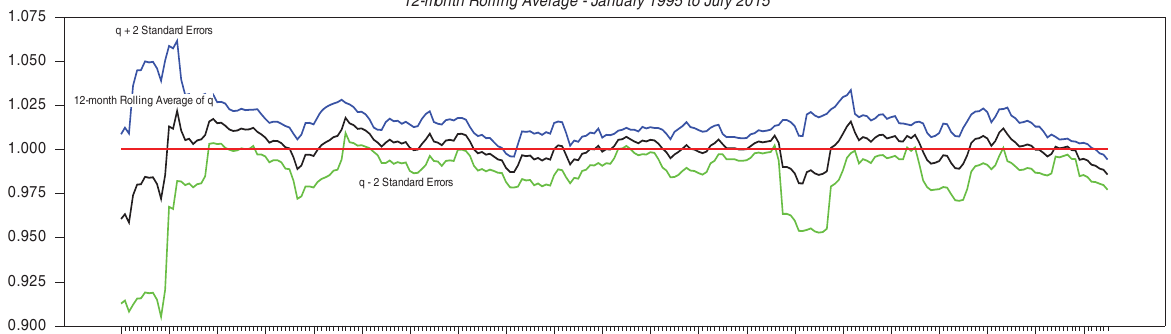
Fig. 11. Mexican peso-U.S. dollar real exchange rate